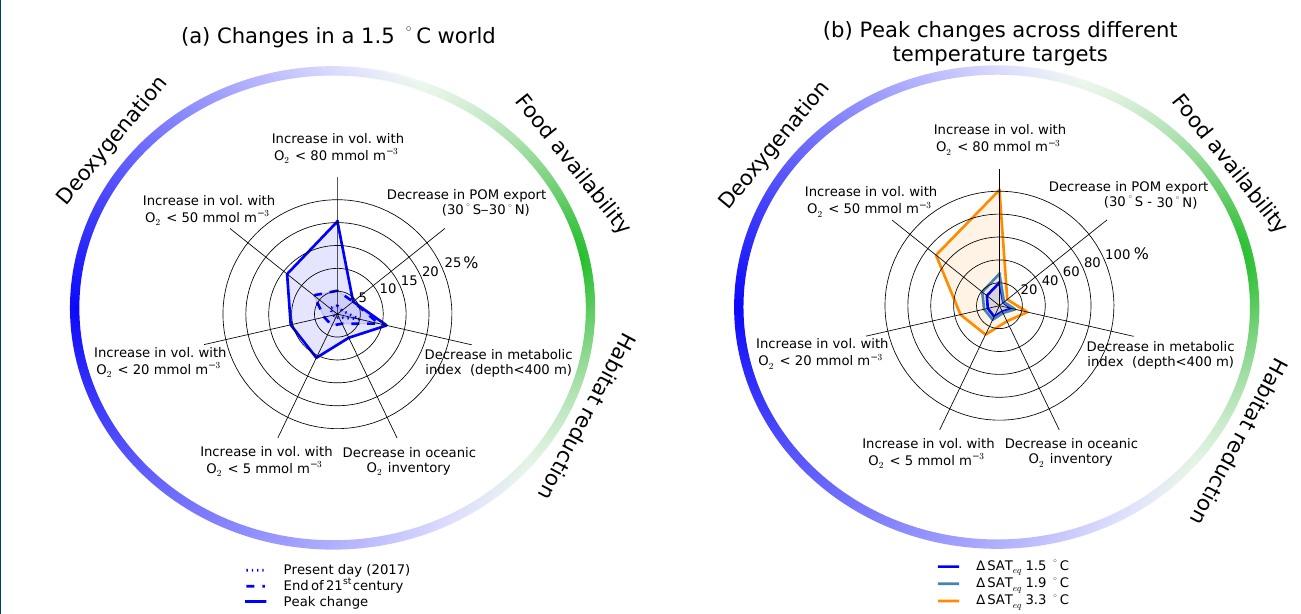
Figure 6. Contrasting hazards of ecosystem impacts expressed in definitions of hypoxia, metabolic viability of the upper ocean and food availability. (a) Changes for a 1.5 ◦ C warmer world at present, at the end of the century and compared to peak changes. (b) Peak changes across 1.5, 1.9 and 3.3 ◦ C temperature targets. Lines correspond to the median response across each ensemble relative to